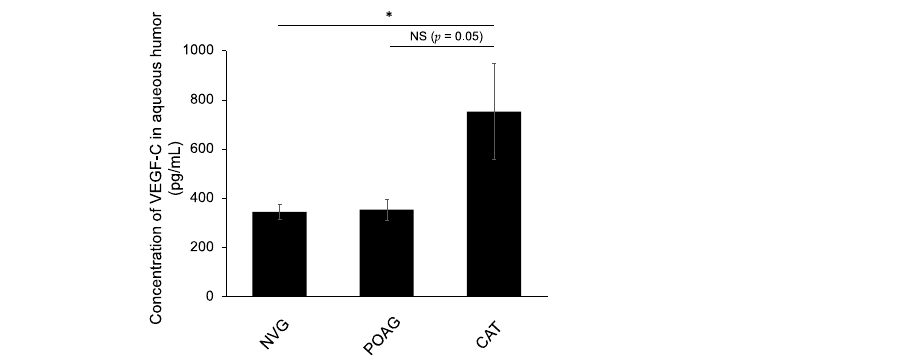
Figure 2. VEGF-C concentrations in the aqueous humor of patients with neovascular glaucoma (NVG), primary open-angle glaucoma (POAG) and non-glaucoma. VEGF-C concentrations of the aqueous humor were measured in patients with NVG ( n = 10), POAG ( n = 6) and cataract ( n = 9). The mean VEGF-C concentrations in the aqueous humor of NVG patients were significantly lower than those of cataract patients (* p < 0.05). The mean aqueous VEGF-C concentrations in POAG patients were almost the same as those in NVG patients.